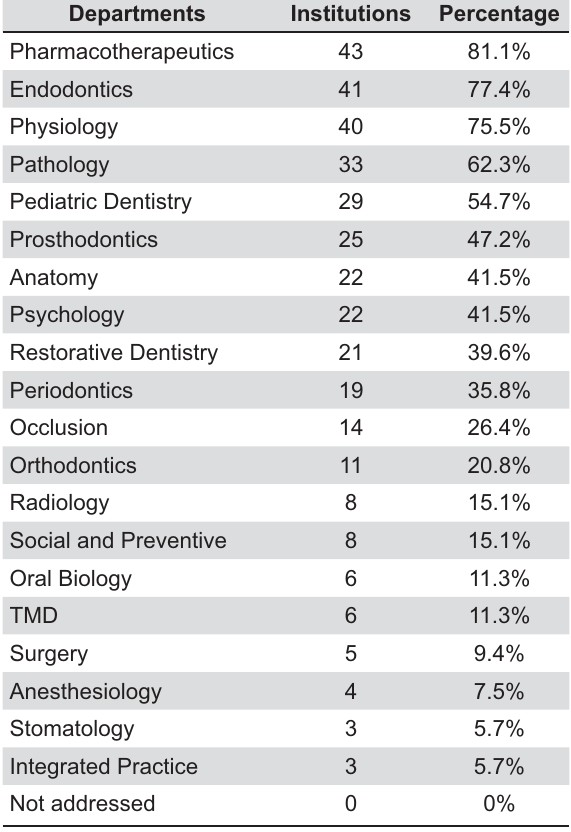
Table 2- Departments responsible for addressing pain mechanisms in undergraduate dental courses